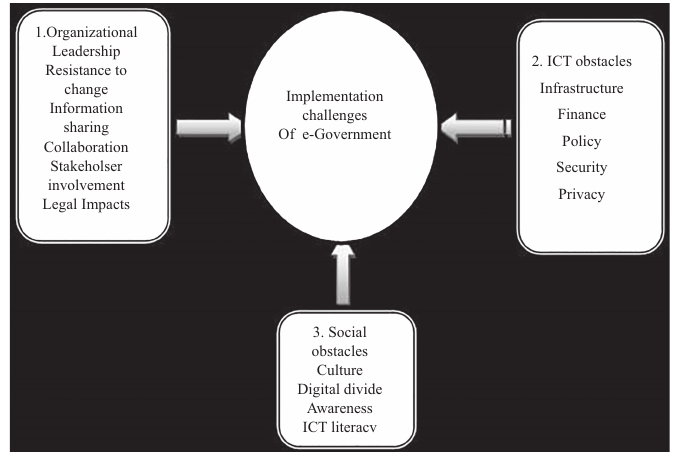
Figure 4. Conceptual